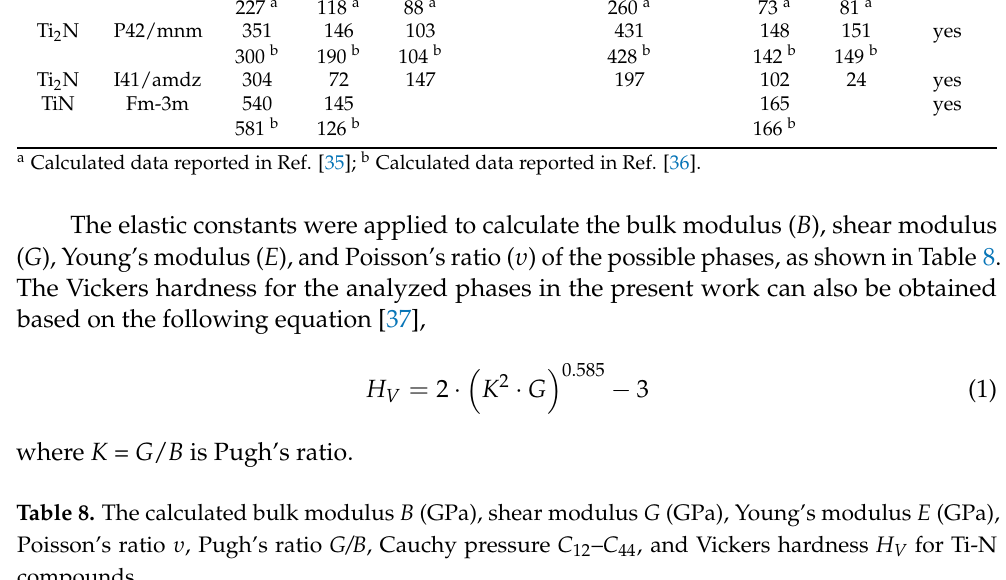
Table 7. The calculated elastic constants for Ti-N compounds. Single-Crystal Elastic Constants (GPa) Space Phase Group C 11 C 12 TiN 0.3 P63/mmc 265